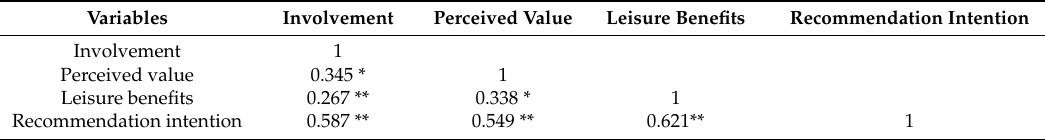
Table 4. Correlation